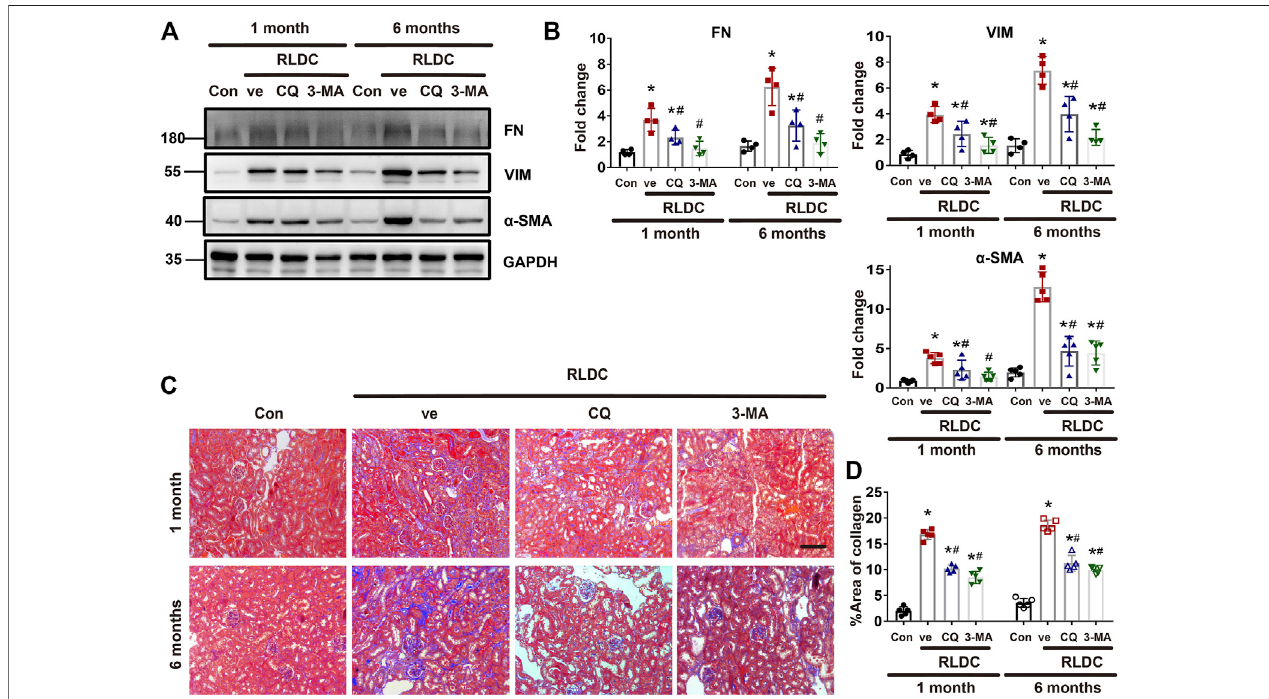
FIGURE3| Inhibitionofautophagysuppressesinterstitial fi brosisafterRLDCregimen.MaleC57BL/6micewereinjectedweeklywith8 mg/kgcisplatinfor4 weeks (RLDC)orwithsaline ascontrol(Con). Afterthe fi naldose, themicewereinjectedwith60 mg/kg/day chloroquine (CQ),20 mg/kg/day 3-methyladenine (3-MA),orsaline asvehiclesolution(ve)for7 days. (A) RepresentativeimmunoblotsofFN,VIM,a-SMAandGAPDH(loadingcontrol)inkidneytissues( n =5). (B) DensitometryofFN,VIM, and a-SMA. The experiments were normalized according to GAPDH expression. The protein level of control group (Con) was arbitrarily set as 1, and the signals of other conditions were normalized with the control group to indicate their protein fold changes. (C) Masson staining of kidney tissues. ( n = 5, bar = 50 μ m). (D) Statistical analysis of area of collagen deposition in Masson staining images. Data are expressed as mean ± SEM. * p < 0.05 vs the control group (Con), # p < 0.05 vs. (RLDC + vehicle)